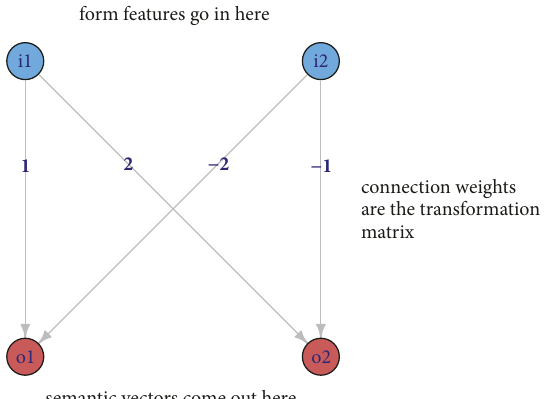
Figure 13: The linear network corresponding to the transformation matrix F . There are two input nodes, 𝑖 1 and 𝑖 2 (in blue),and two output nodes, 𝑜 1 and 𝑜 2 , in red. When the input vector (3,4) is presented to the network, the value at 𝑜 1 is 3 × 1 + 4 × −2 = −5 and that at 𝑜 2 is 3 × 2 + 4 × −1 = 2 . The network maps the point (3, 4) onto the point (−5,2)